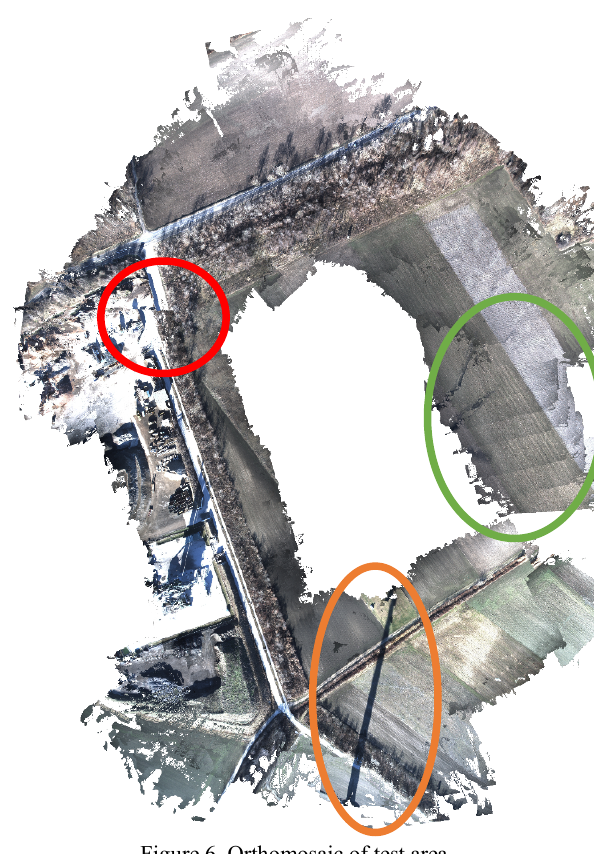
Figure 6. Orthomosaic of test area